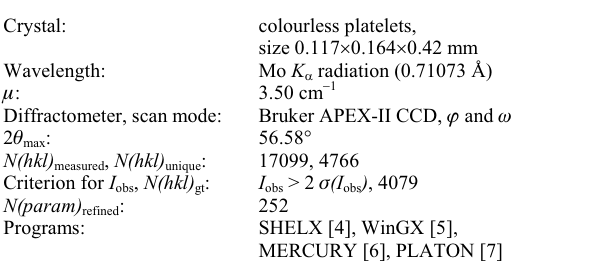
Table 1. Data collection and